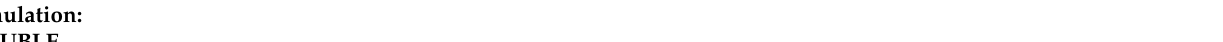
Table 3. The theoretical and simulation of pumping systems for 148 dm 3 and 296 dm 3 active